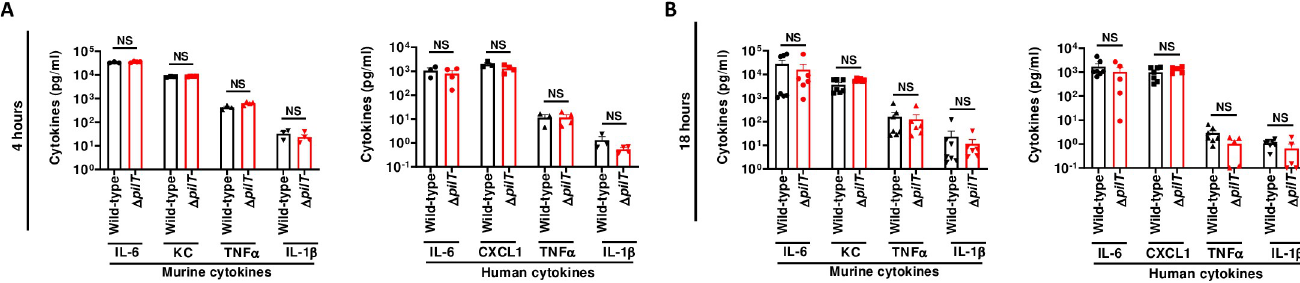
Fig 3. N . meningitidis WT and Δ pilT induce equivalent inflammatory responses (A, B) Serum levels of proinflammatory mouse and human cytokines were measured in grafted mice infected IV with 5x10 6 CFU of N . meningitidis WT strain or isogenic Δ pilT mutant at 4 h (A) and 18 h (B) post-infection using multiplex assays. Two independent experiments, n = 4, 5 or 6 mice per group. Bars represent mean ± SEM, NS p > 0.05, unpaired t-test.